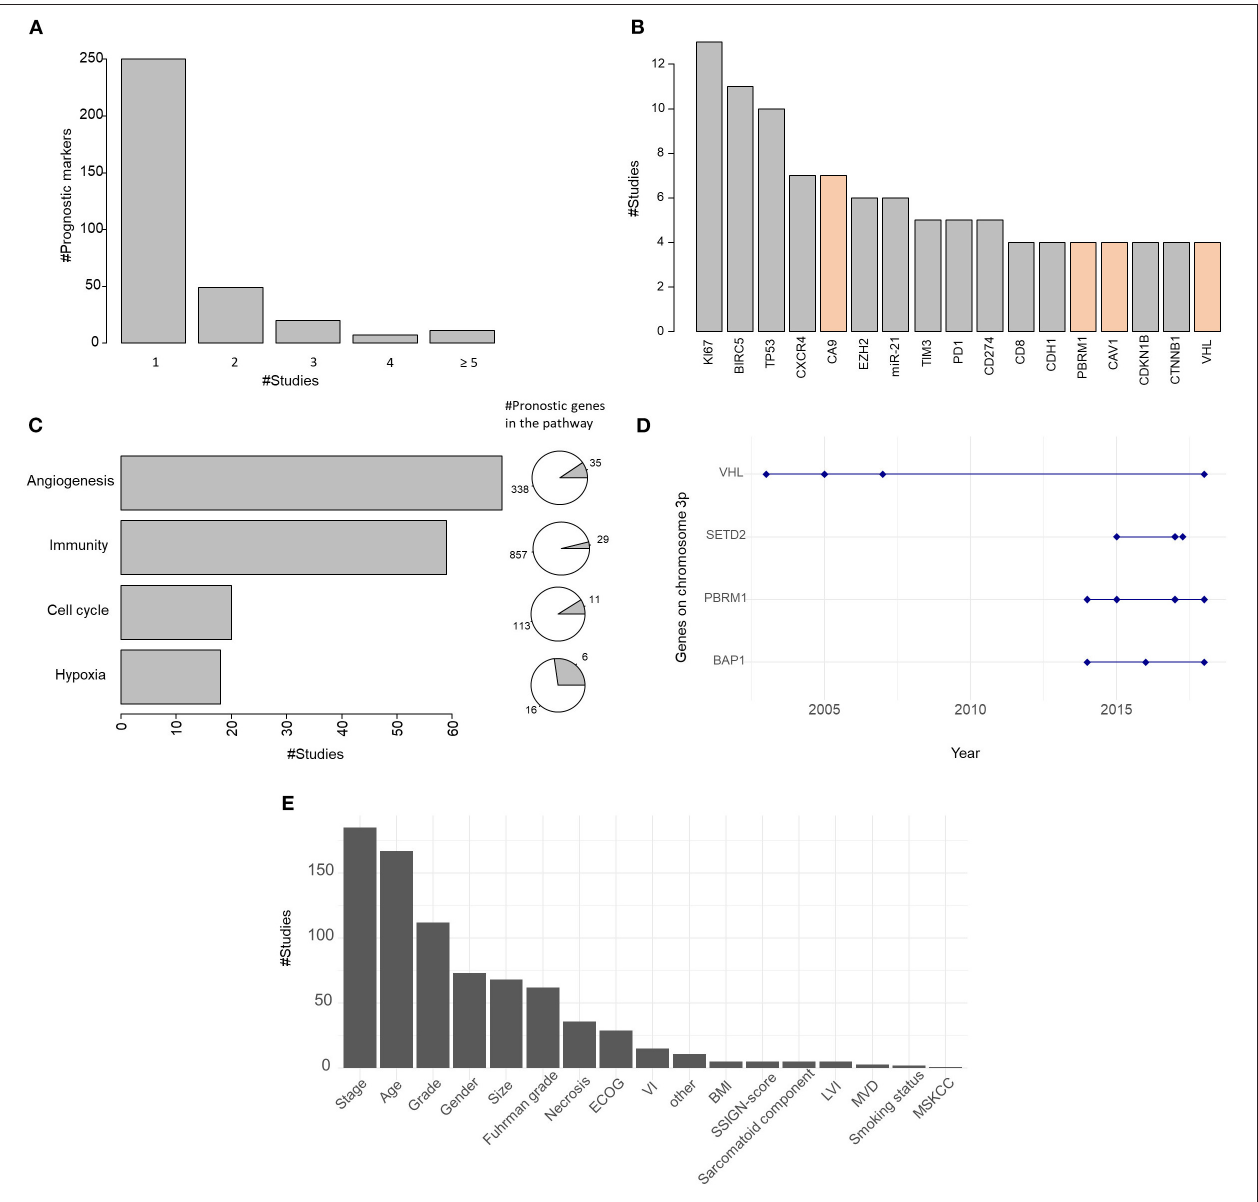
FIGURE 2 | (A) Barplot of the number of markers cited in one or more studies. (B) Barplot of the most investigated prognostic markers. In orange are indicated prognostic markers specific to clear cell renal cell carcinoma (ccRCC). (C) Barplot of the number of studies investigating markers involved in the main biological pathways: angiogenesis, immunity, cell cycle, and hypoxia. Pies on the right represent the proportion of prognostic markers in the pathway. (D) Distribution of the studies assessing the prognostic value of genes on chromosome 3p over the years. (E) Barplot of the number of studies integrating clinical covariates. ECOG, Eastern Cooperative Oncology Group; VI, vascular invasion; BMI, body mass index; SSIGN, Stage, Size, Grade, and Necrosis; LVI, lymphovascular invasion; MVD, microvessel density; MSKCC, Memorial Sloan Kettering Cancer Center. about 30% of the genes involved in the hypoxia pathway, are reported as prognostic markers in 18 publications. Of note,